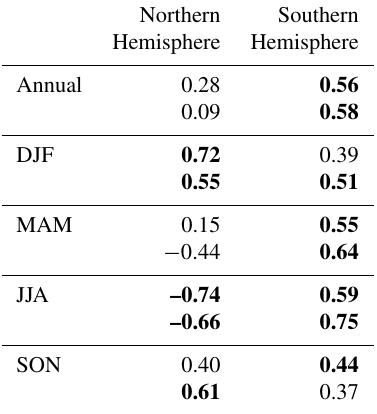
Table 3. Correlations between the poleward shift of the Hadley cell edge latitude in response to 4 × CO 2 forcing (as measured by PSI500 metric) with the annual-mean global-mean surface temperature re- sponse to 4 × CO 2 forcing. Positive correlations imply that models that warm more shift the Hadley cell edge further poleward. Cor- relations for CMIP5 and CMIP6 models are shown in the top and bottom rows of each cell, respectively. Correlations that are statisti- cally significant at the 95% confidence level via Student’s t test are bolded. Northern Southern Hemisphere